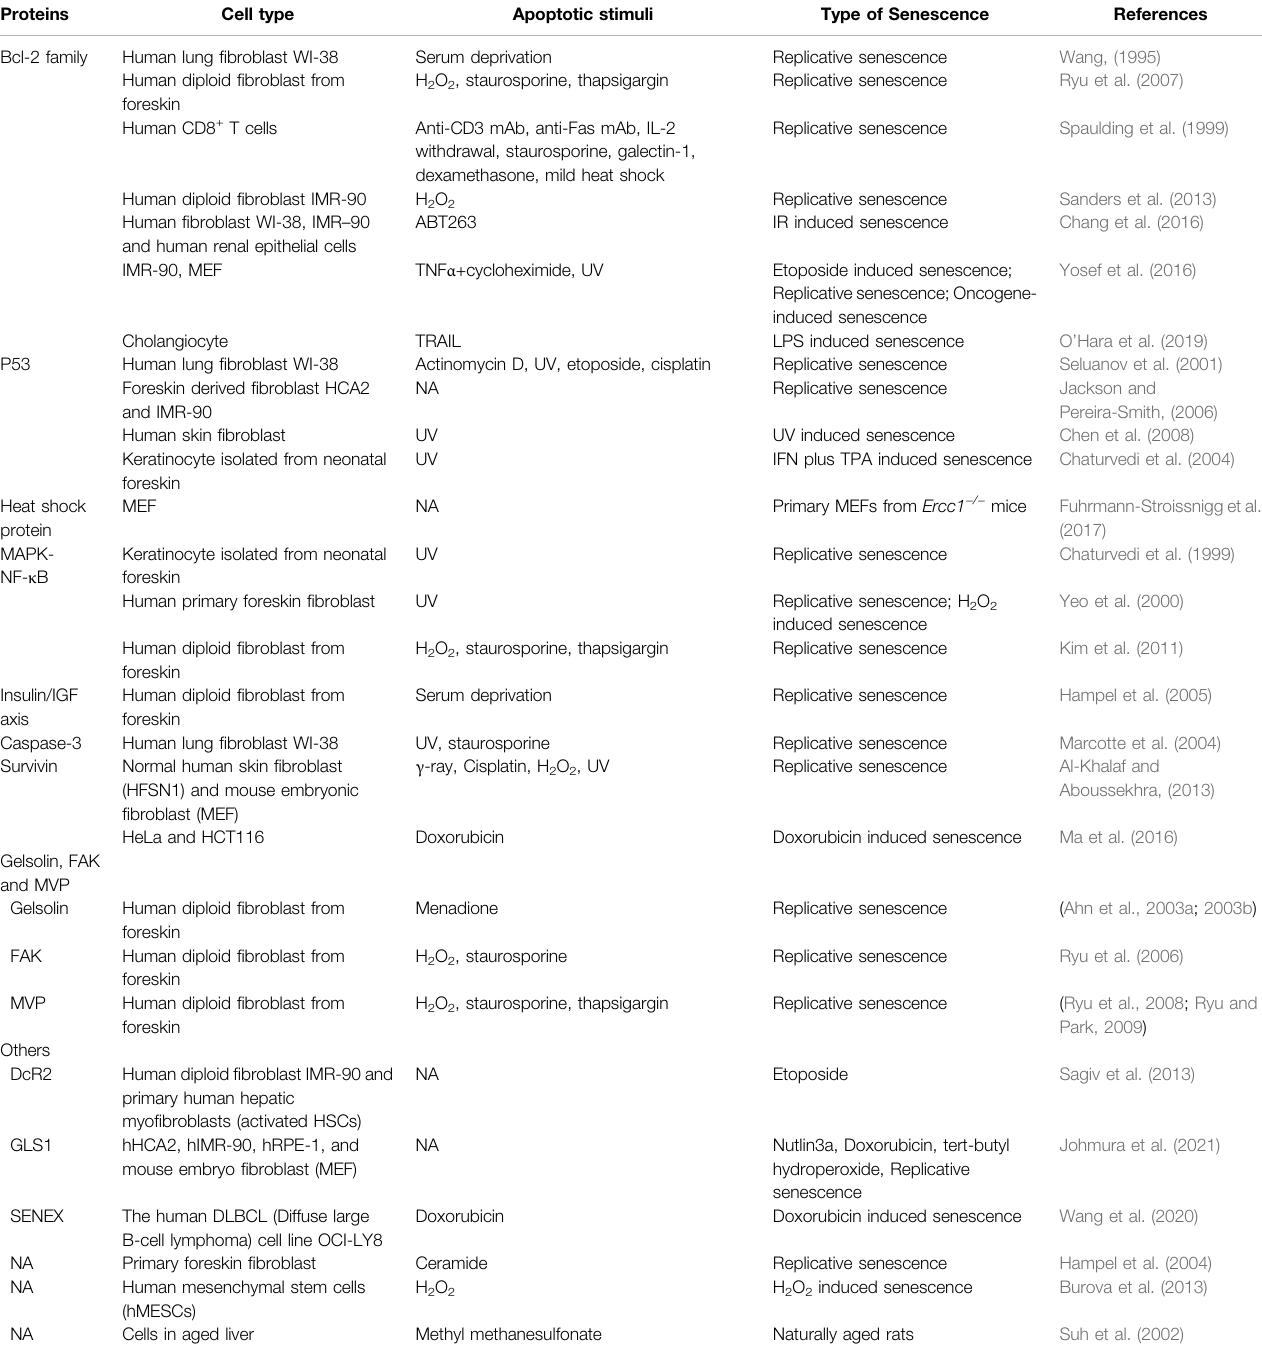
TABLE 2 | Proteins implicated in the apoptotic resistance of senescent cells (SnCs).